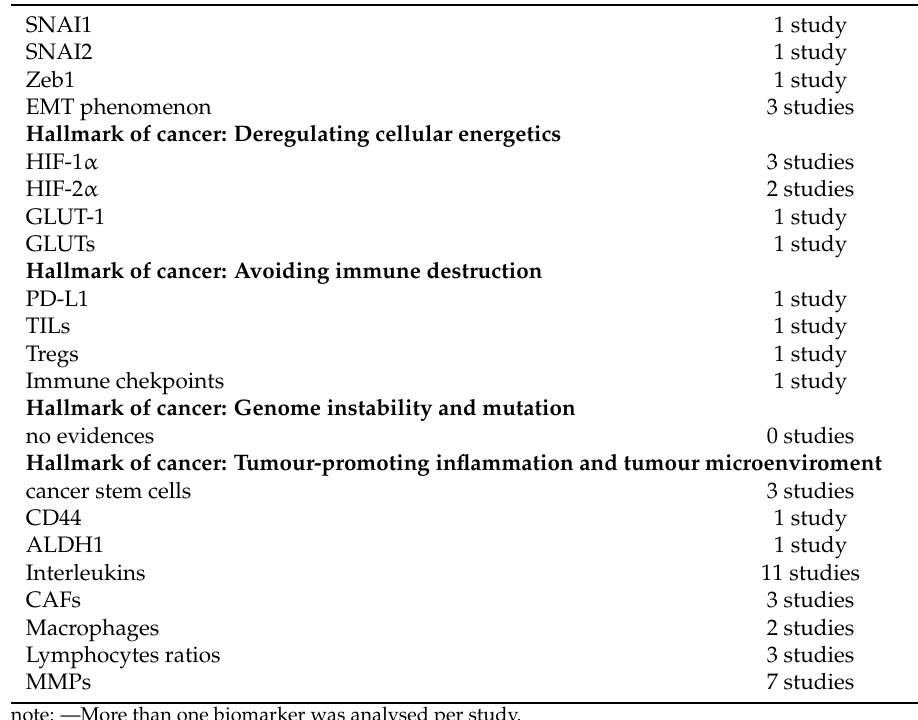
Table 3. Systematic reviews and meta-analyses published (n =